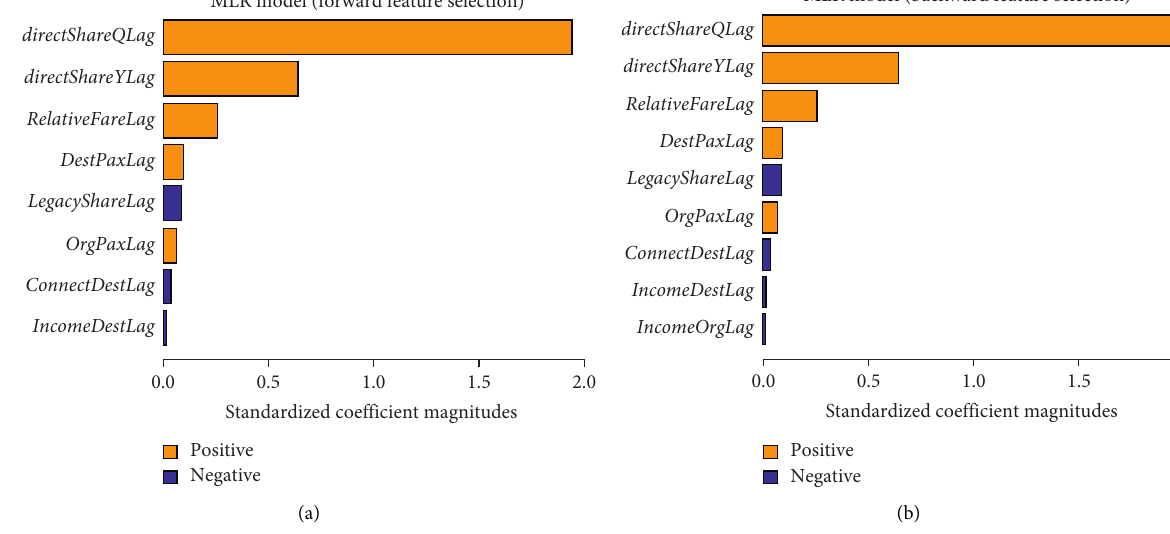
Figure 5: Variable importance of MLR models developed with forward and backward feature